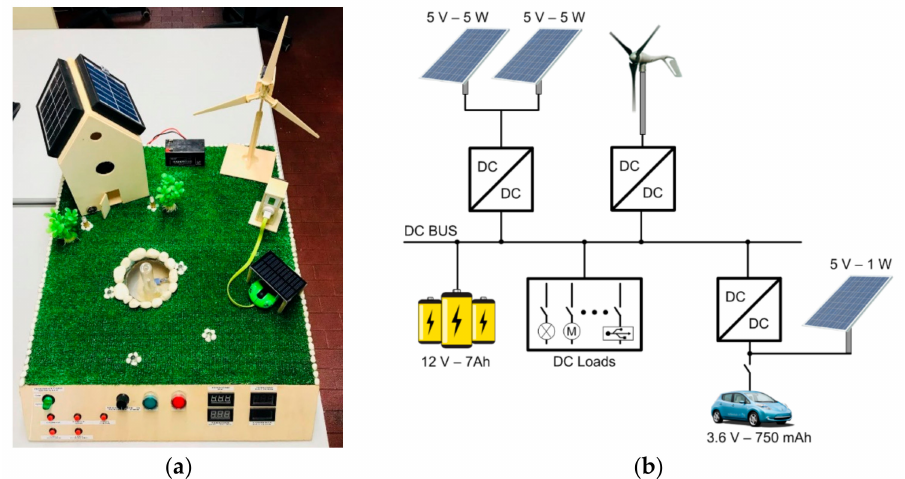
Figure 2. Didactic smart microgrid demonstrator: ( a ) picture and ( b ) functional scheme of the